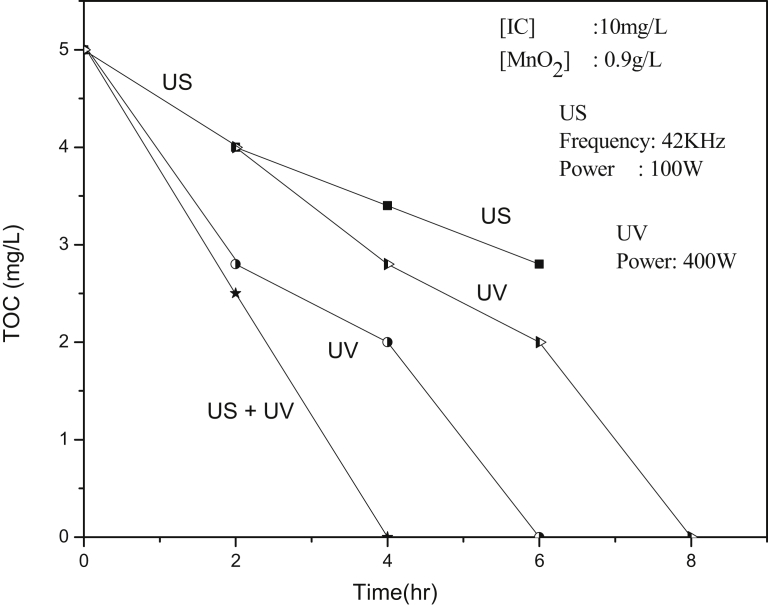
TOC of MnO2/IC system under various conditions of activation.